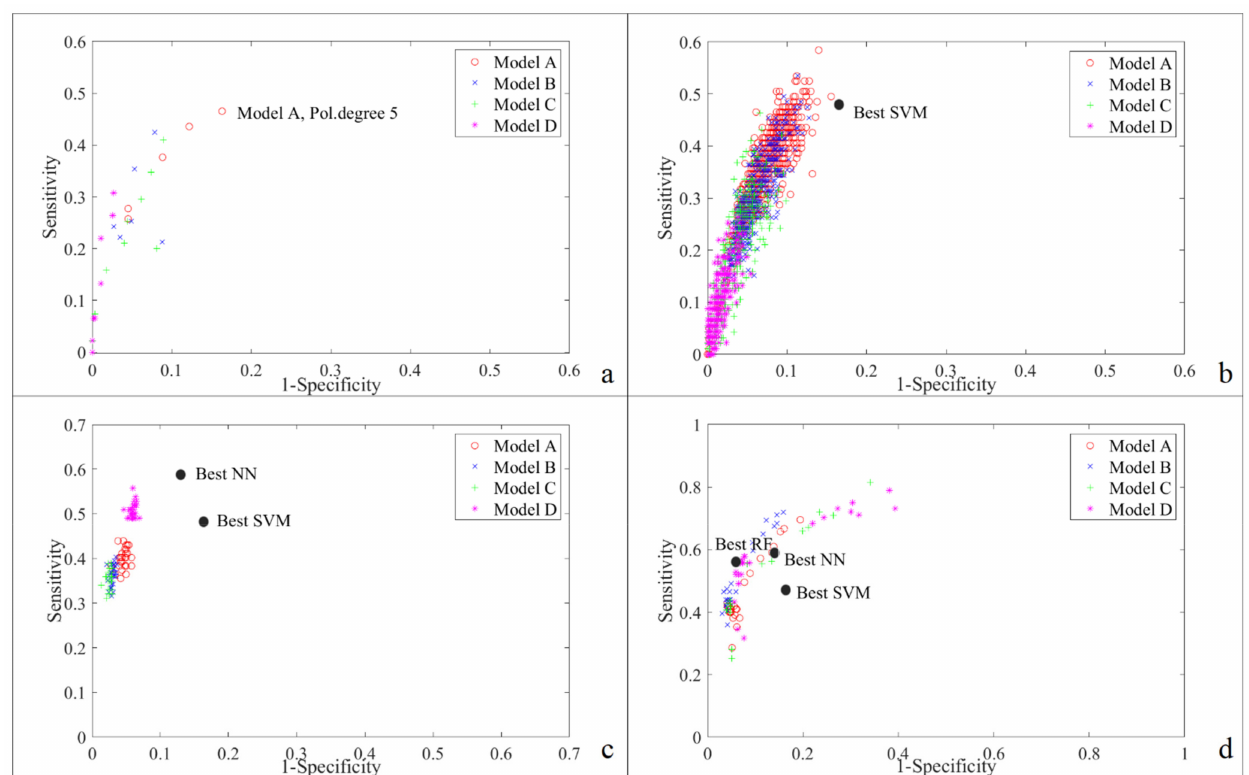
Figure 4. ROC curves plotting classification results computed from the validation set for models based on different parametric configurations and variable combinations (A, B, C or D) for the four machine learning methods used in this work: ( a ) SVM; ( b ) MLP NN; ( c ) RF; and ( d )